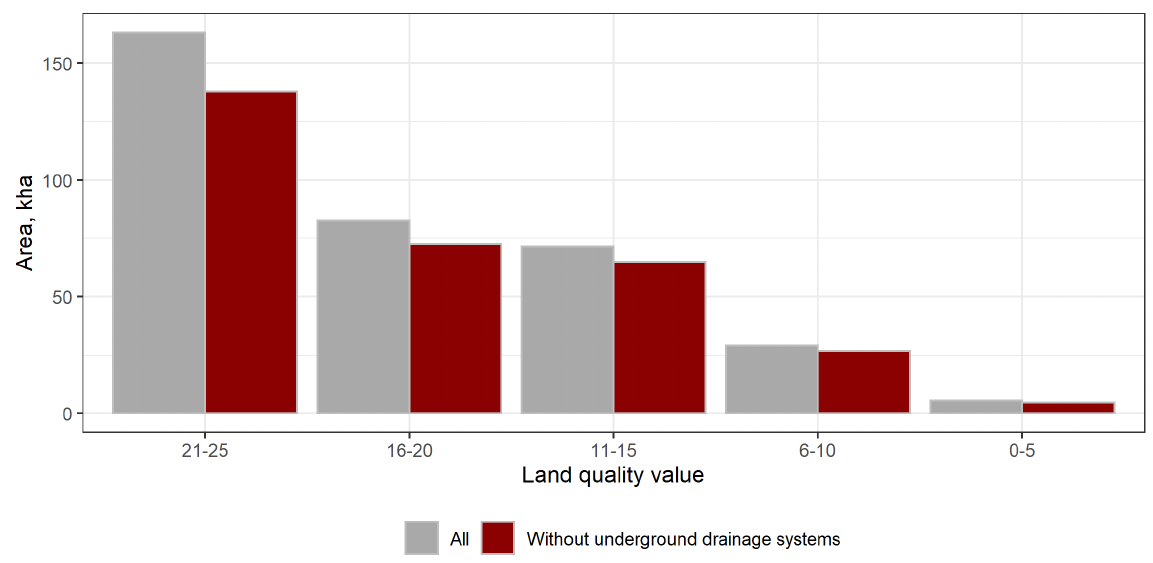
Figure 4. Area of low-value agricultural land parcels suitable for agroforestry by groups of land-quality values.